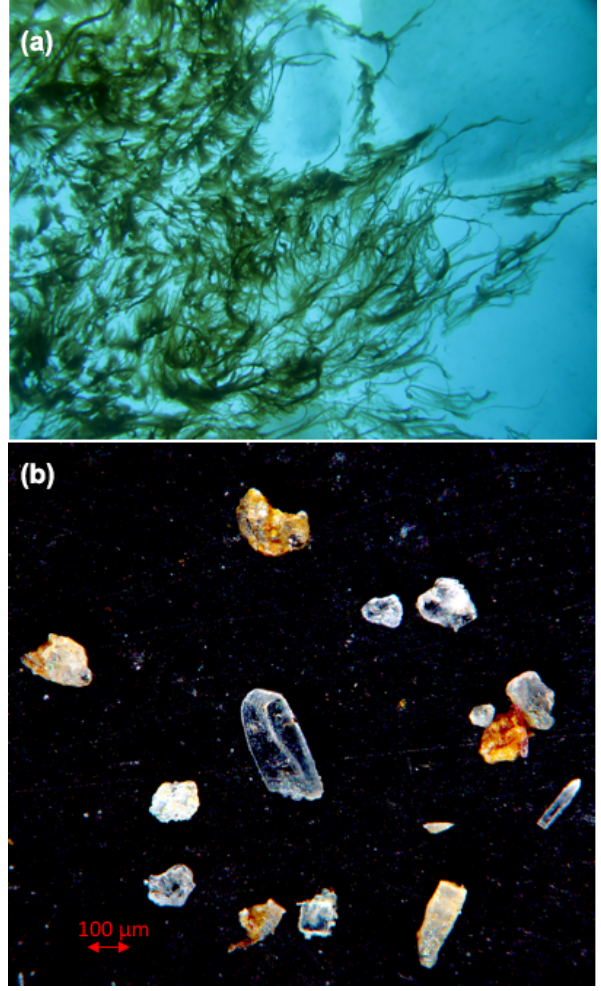
Figure 8. ( a ) Living Melosira arctica curtains hanging from ice floes during the PS106 expedition (photo taken by Marcel Nico- laus and Christian Katlein). (b) Cryogenic gypsum isolated from Melosira arctica (PS106/1, station 21; Peeken at al., 2018b).